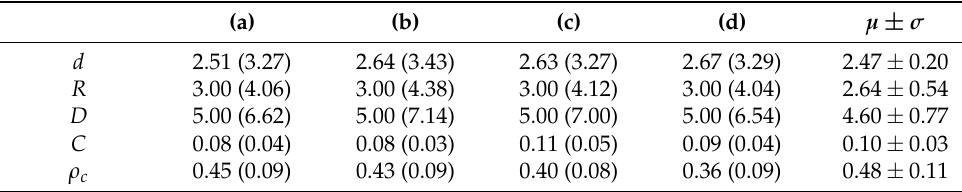
Table 2. Topological parameters of the kinetic networks of WDSL ensembles illustrated in Figure 2: average path distance d , radius R , diameter D , transitivity C and ground-state connectivity density ρ c . The corresponding averages µ and standard deviations σ are obtained from 100 different realizations of disorder. For the sake of comparison, the values in brackets indicate the results for random graphs having the same number of nodes and